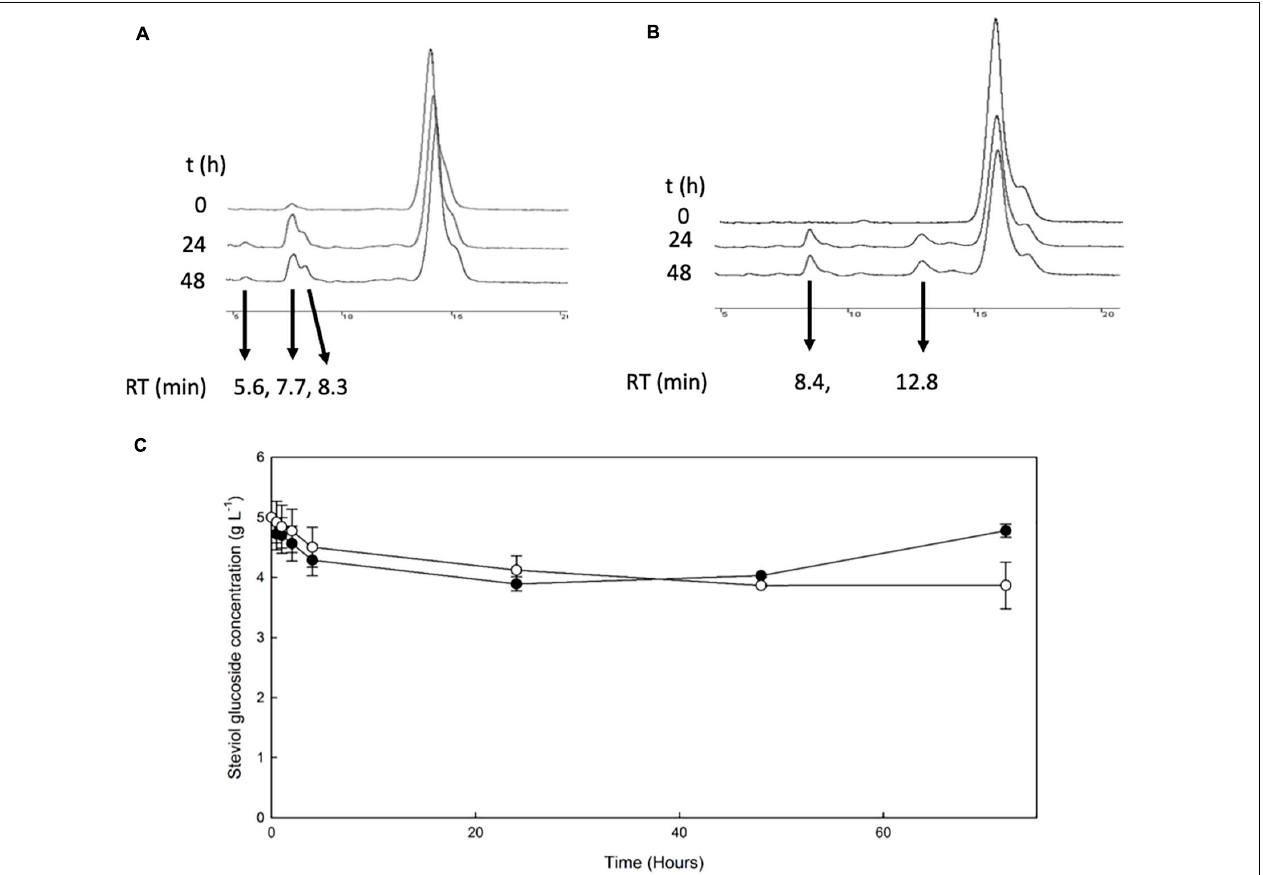
FIGURE 4 | Transglycosylation of steviol glycosides by Mt Bgl3a. HPLC chromatograms of the reaction mixture of Mt Bgl3a with stevioside (A) and RebA (B) , with cellobiose as the donor. (C) Mt Bgl3a -mediated bioconversion of stevioside ( black squares ) and RebA ( white circles